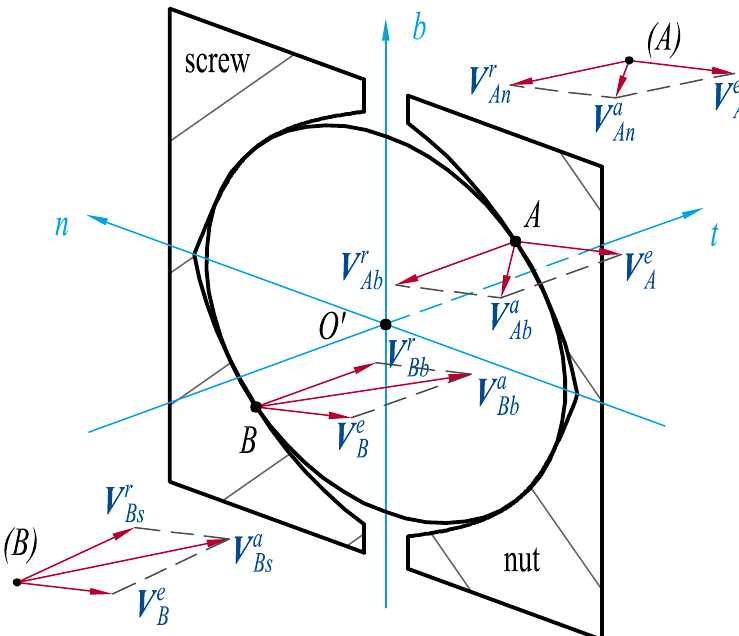
Figure 3. Linear velocities of the ball and